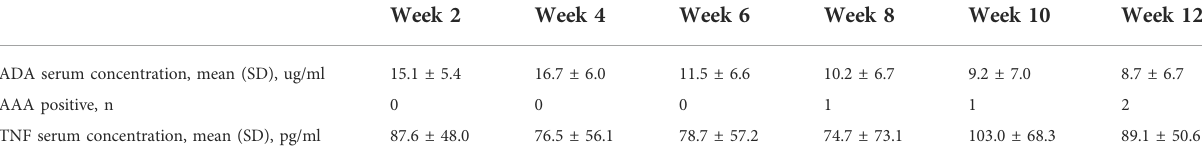
TABLE 4 ADA relatated indicators monitoring in patients with CD, n =